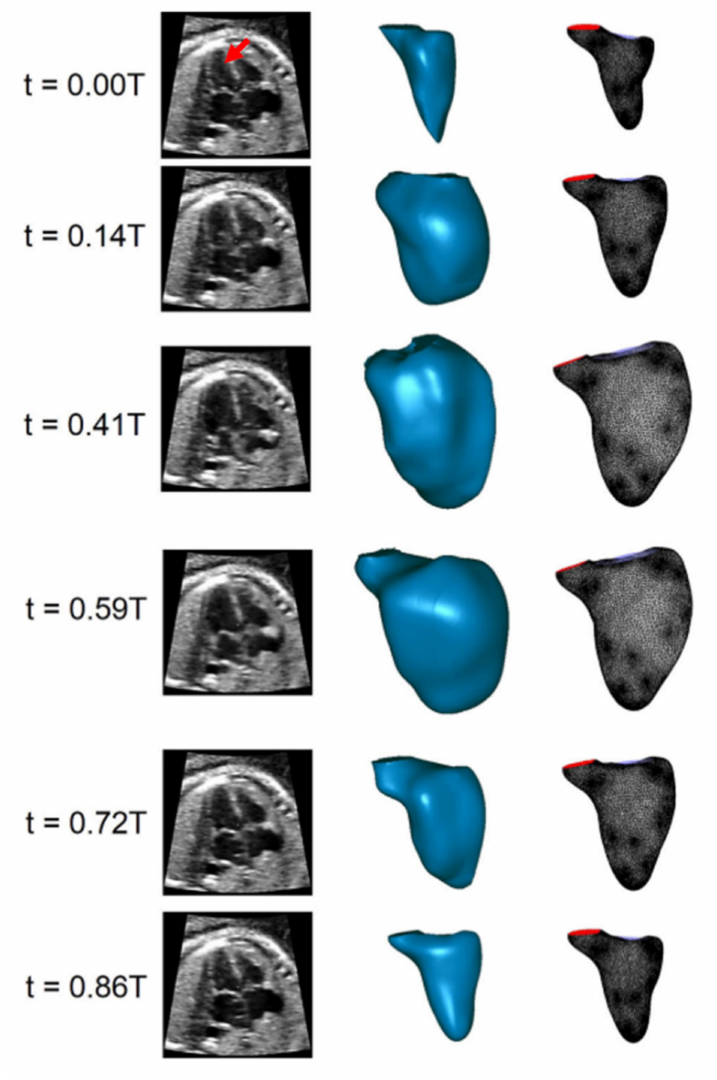
Figure 6. Ultrasound images of fetal hearts ( first column ). Reconstructed 3D models ( second column ) and generated meshes ( third column ) of fetal left ventricle over the cardiac cycle. Fetal left ventricle is shown by the red arrow in the ultrasound image at t = 0 T, where T is the period of one cardiac cycle (Reproduced from Lai et al. (2016)